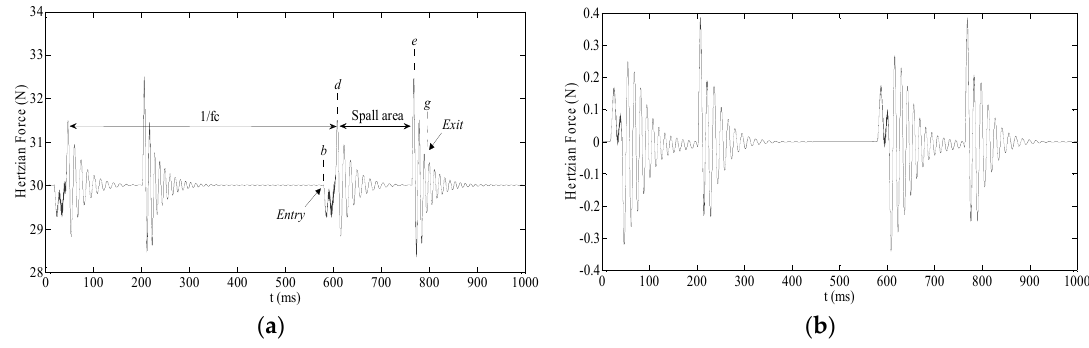
Figure 5. The total Hertzian forces along the X-axis and Y-axis: ( a ) X-axis total Hertzian forces F X ; ( b ) Y-axis total Hertzian forces F Y .